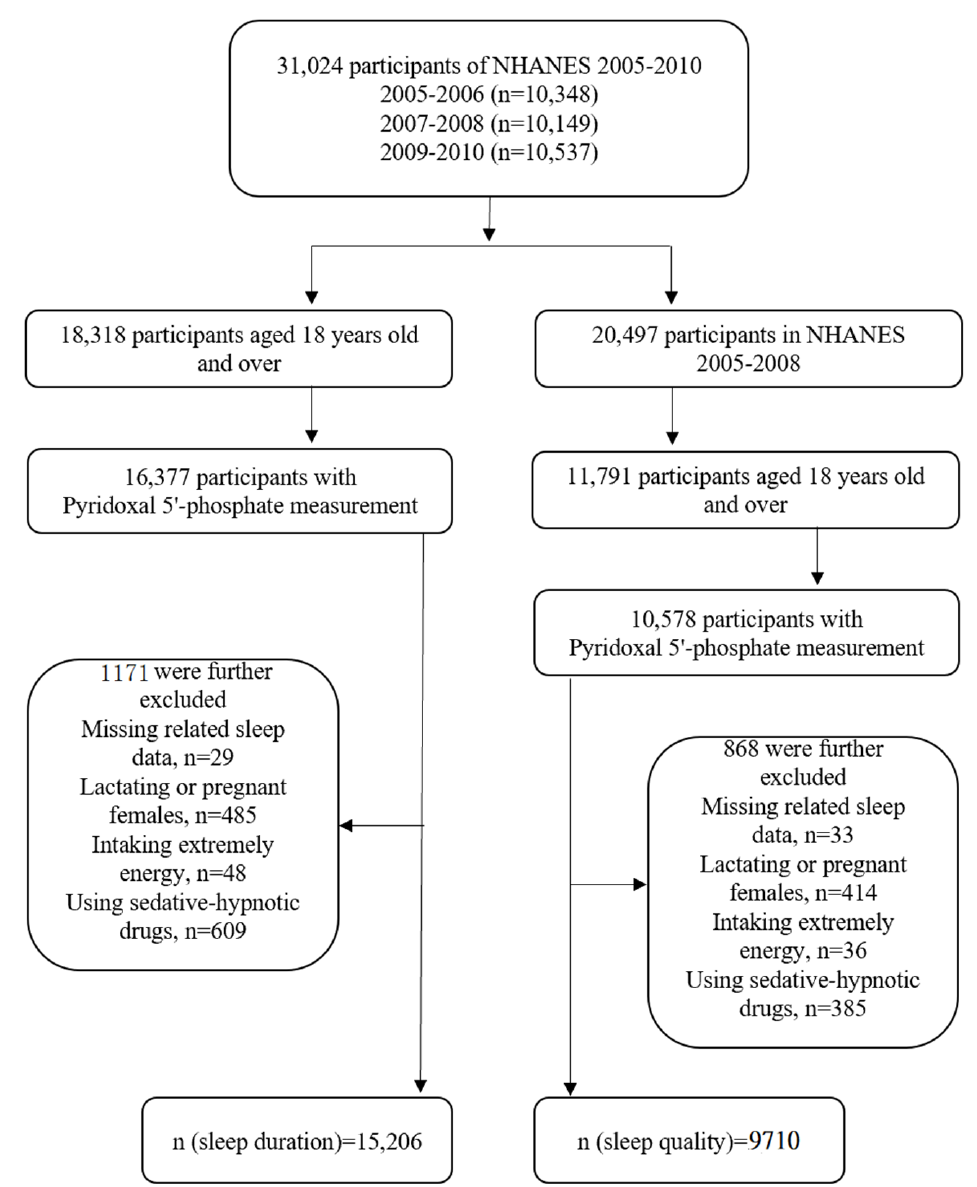
Figure 1. Flowchart of the screening process for the selection of eligible participants.